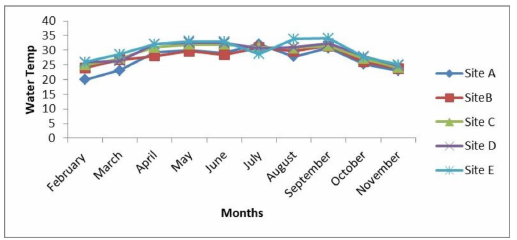
Figure 2. Monthly mean variations in temperature of Nasarawa Reservoir.